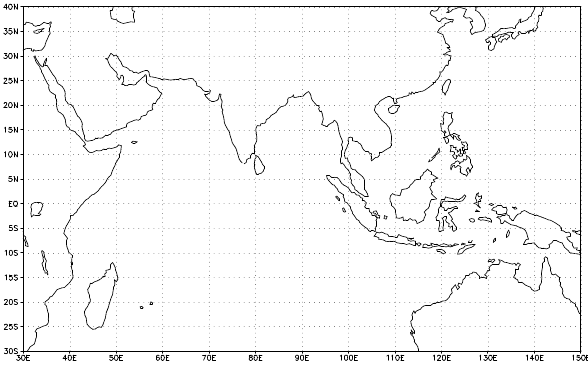
Fig (1): Selected domain for the study Fig. 1. Selected domain for the study.